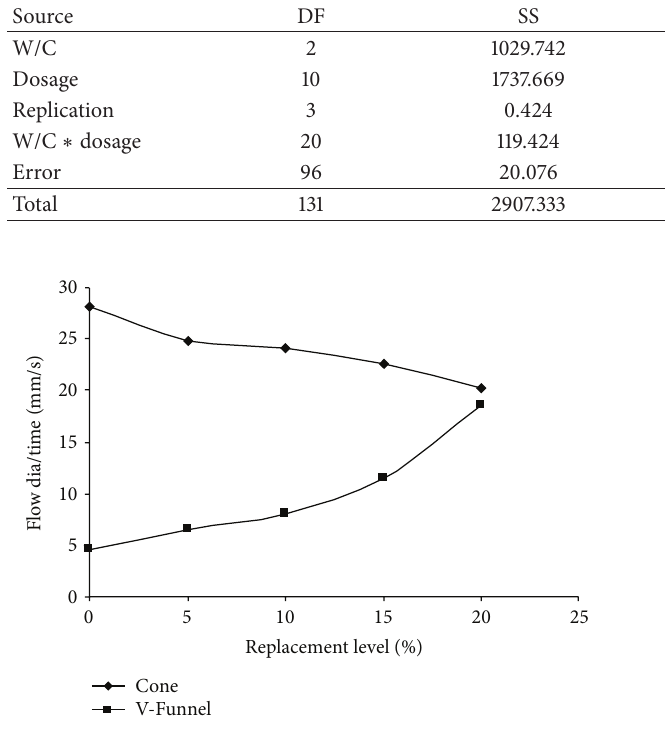
Figure 5: Flow/time for powder content